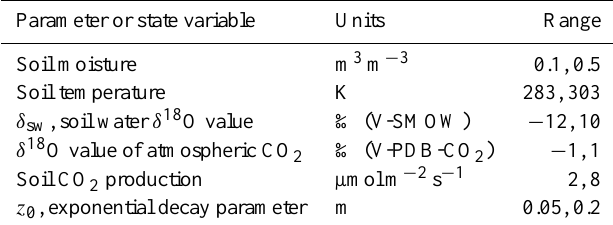
Table 1. Parameters and state variables used to generate the expan- sion functions. Spatial discretization scenarios D 1 and D 2 corre- spond to eight 2.5cm and four 5cm control volumes, respectively, in the top 20cm of soil. All HDMR simulations are performed by dividing each parameter range into 100 equal spaces (i.e., N =